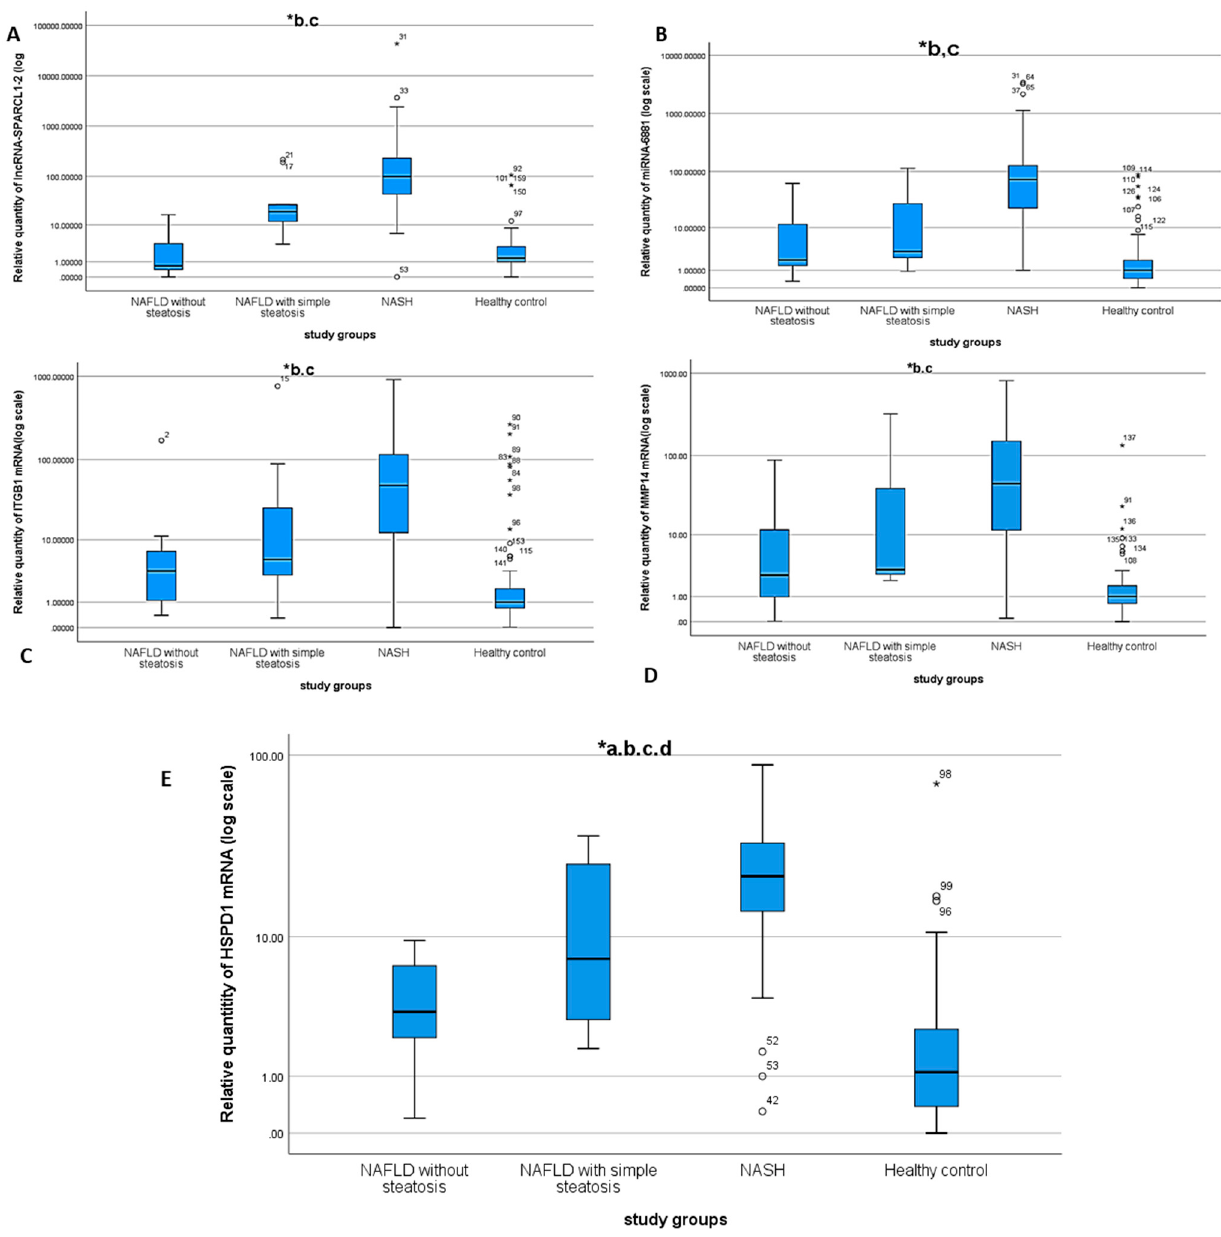
Figure 2. Differential expression of lnc-SPARCL1-1:2 ( A ) miR-6881-5p miRNA ( B ), ITGB1 mRNA ( C ), MMP14 mRNA ( D ) and HSPD1 mRNA ( E ) * statistically significant difference by Tukey post-hoc test in a healthy control vs. NAFLD without steatosis, b healthy control vs. NASH, c NAFLD without steatosis vs. NASH, d NASH vs. simple steatosis.